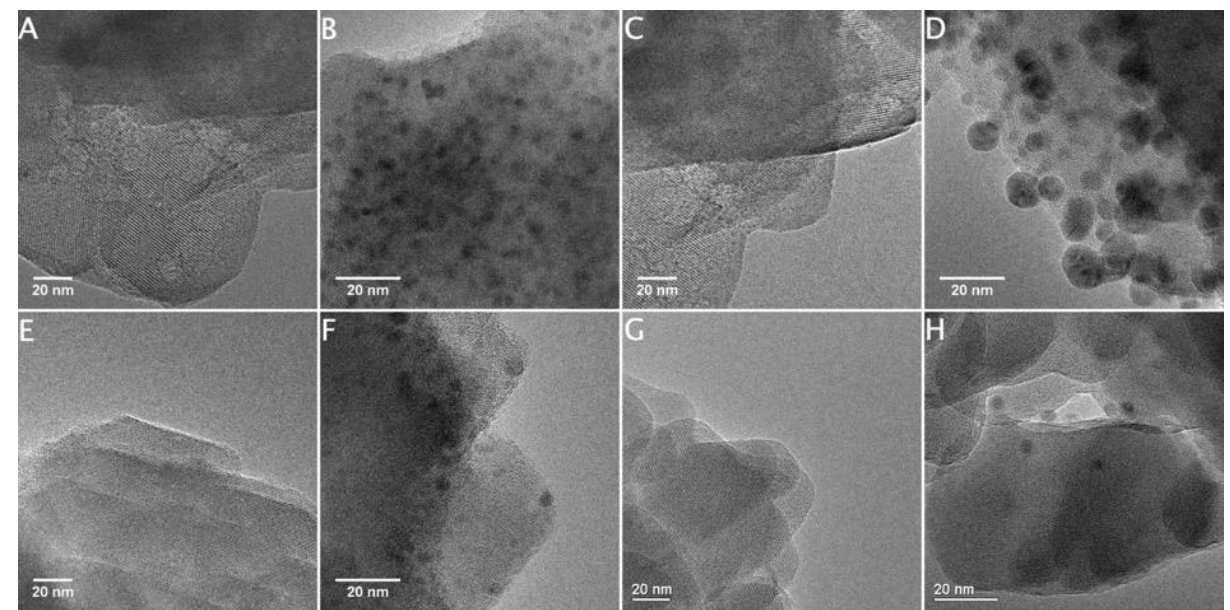
Figure 1. HRTEM images of the catalysts: ( A , B ) CuYs, ( C , D ) Cu/USYs, ( E , F ) Cu/ZSM-5-15s. ( E – H ) Cu/ZSM-5-37s. The catalysts were also examined by µ Raman spectroscopy (Figure 2A,B). The µ Raman spectra of Y/USY based zeolites revealed bands at 220, 322, 384, 495 and 660 cm − 1 , albeit only for Cu/USY/s (Figure 2A). The analysis of the Raman spectra of Cu modified ZSM-5 zeolites reveals four bands at 290, 379, 468 and 800 cm − 1 (Figure 2B). These bands may be due to framework vibrations.